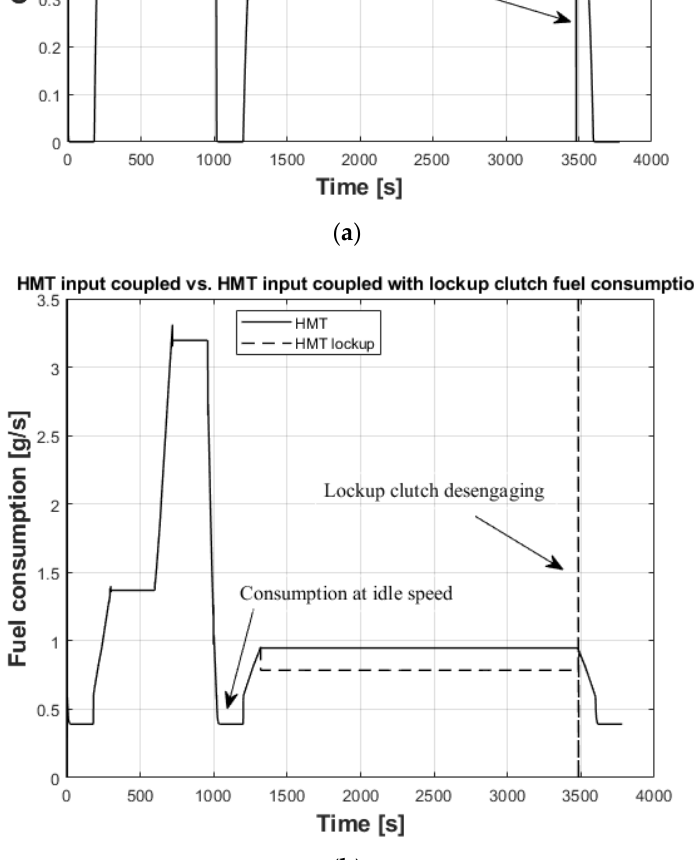
Figure 17. Comparison between input-coupled HMT and input-coupled HMT with lockup clutch through UNI-EN 15429-2 cycle. ( a ) Global efficiency. ( b ) Fuel